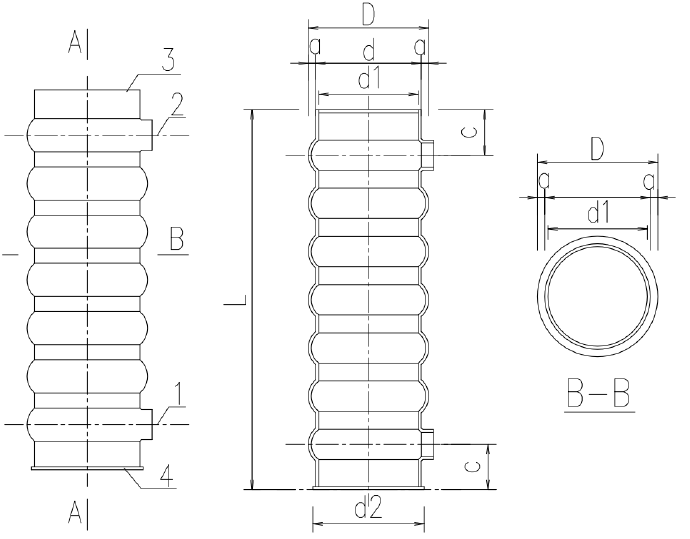
Figure 2. The new GCD connection design.